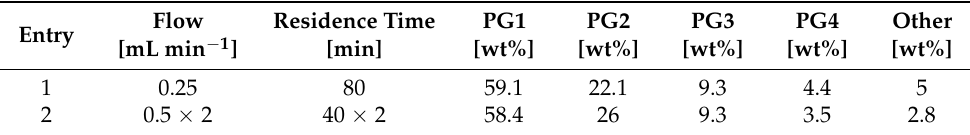
Table 2. Microwave-assisted continuous oligomerization of glycerol with peristaltic pump in serial mode (GC analysis) 1 .